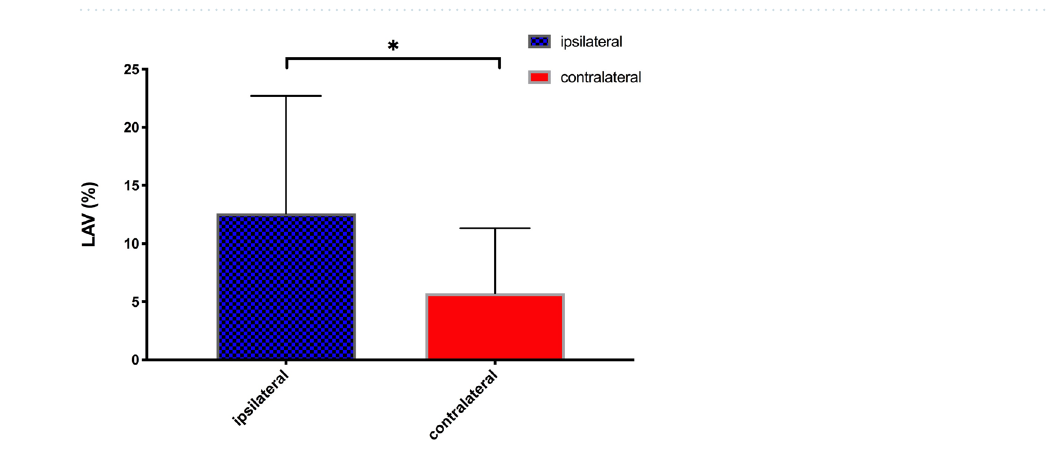
Figure 1. CT data of 10 year old child after CDH repair. Child after left sided CDH repair. The visual evaluation of the images already reveals lower density values on the ipsilateral/left side. On the right: Colour coded image of lung density (green shows normal lung density, blue codes hypoattenuated lung parenchyma).